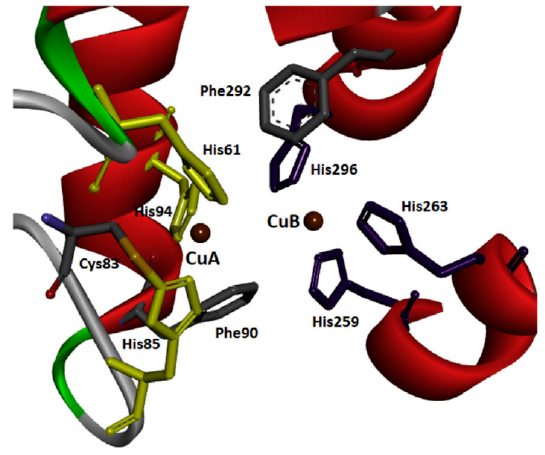
Figure 2. Geometry of the binuclear copper-binding site for isolated and purified tyrosinase from Agaricus bisporus . Reprinted with permission from [35]. Copyright 2023, copyright Elsevier.